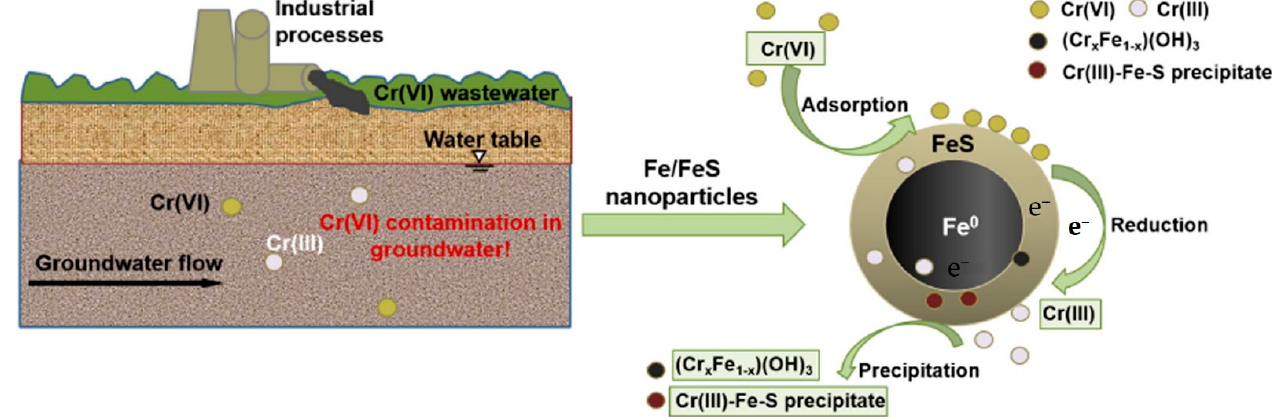
Figure 3. Groundwater remediation using Fe/FeS nanoparticles. Reprinted with permission from [80] (2017,